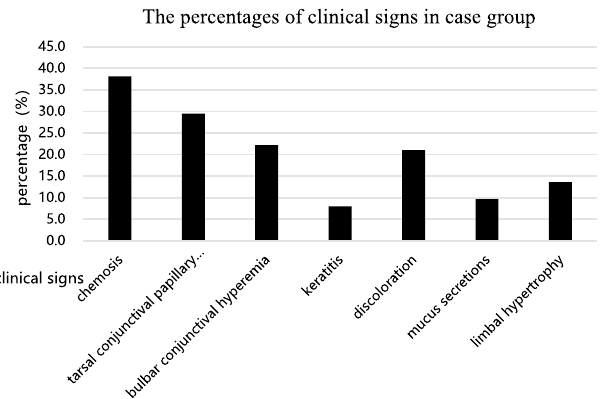
Figure 2. The percentages of clinical signs in case group. 38.1% of AC patients had chemosis (n = 67); 29.5% had tarsal conjunctival papillary hypertrophy (n = 52); 22.2% had bulbar conjunctival hyperemia (n = 39); 8.0% had keratitis (n = 14); 21.0% had discoloration (n = 37); 9.7% had mucus secretions (n = 17); 13.6% patients had limbal hypertrophy (n = 24).